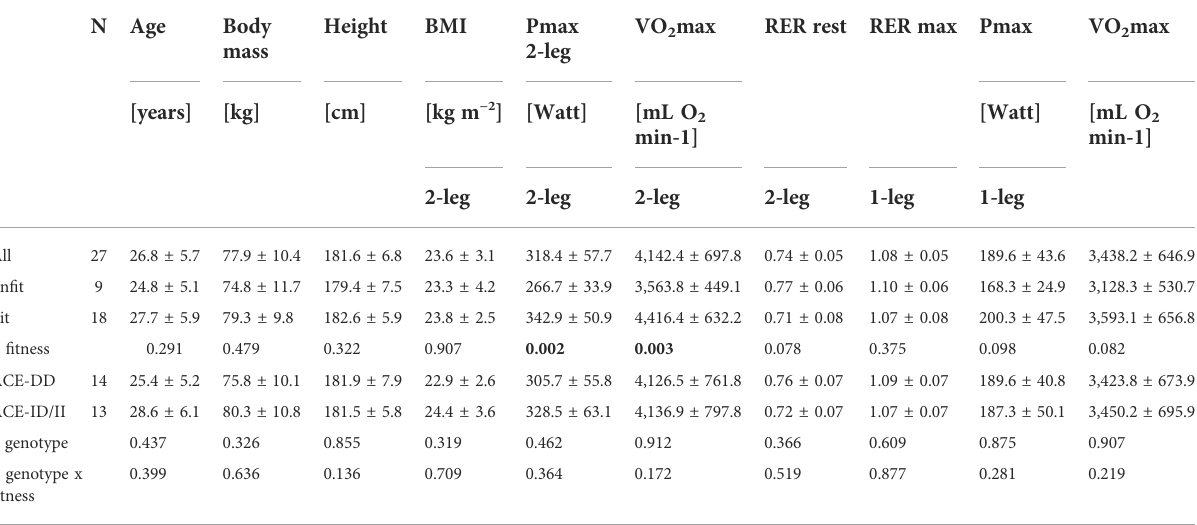
TABLE 1 Physiological